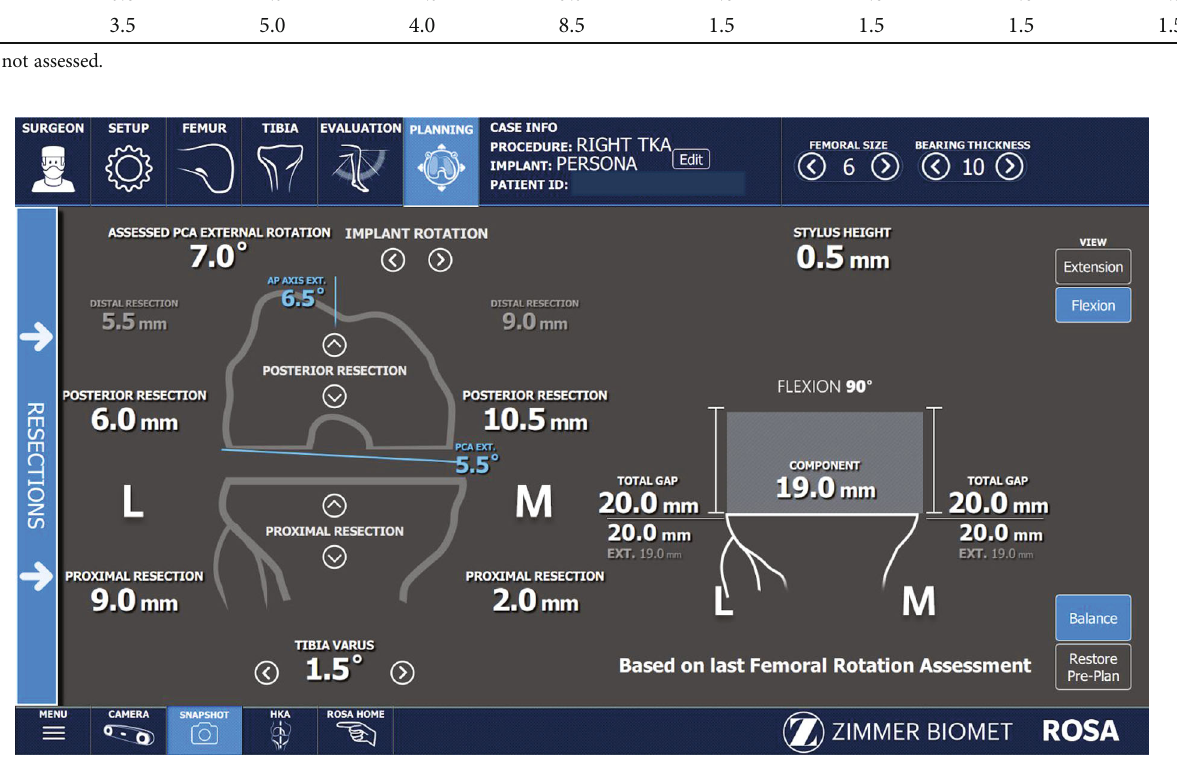
Figure 2: An intraoperative surgeon generated plan for femoral resections of Case